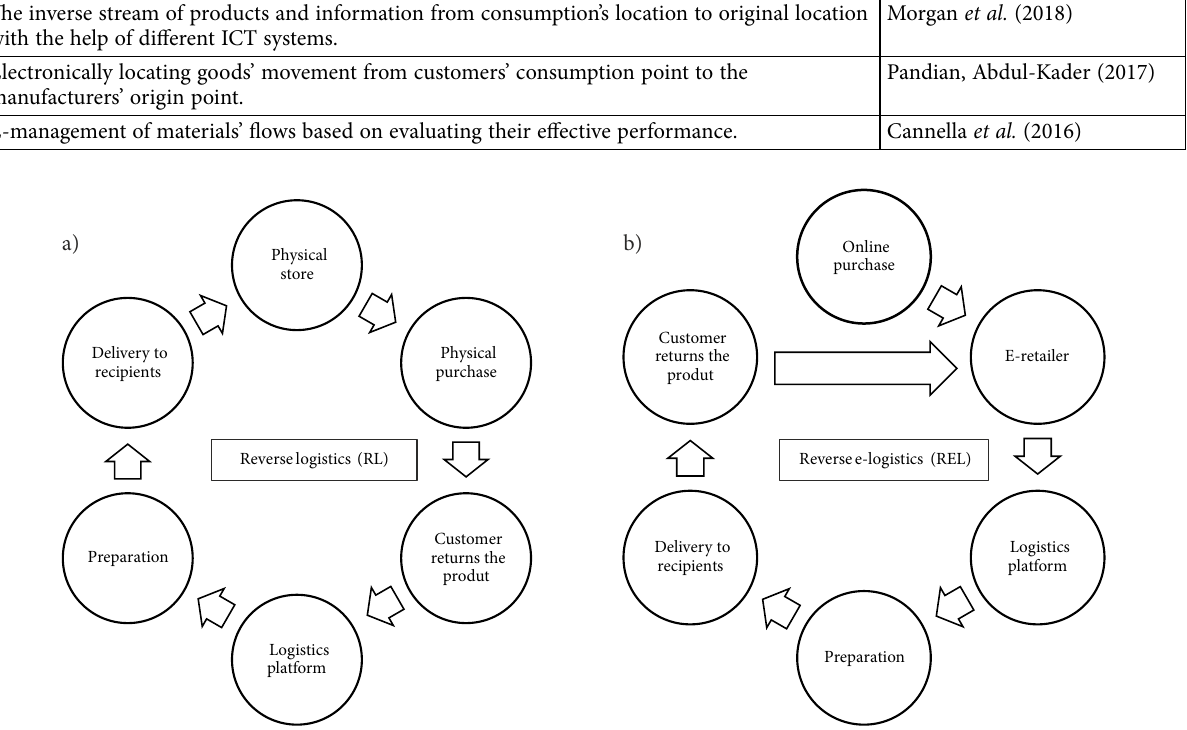
Table 2. Main definitions of REL (source: compiled by authors) Definition of REL